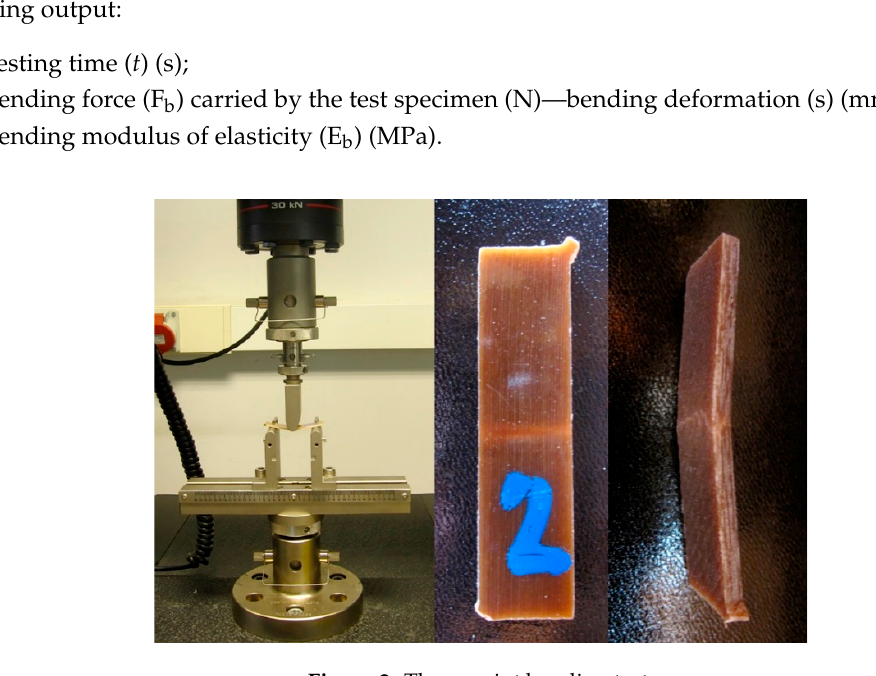
Table 1. General properties of hemp fibre-reinforced plastic.